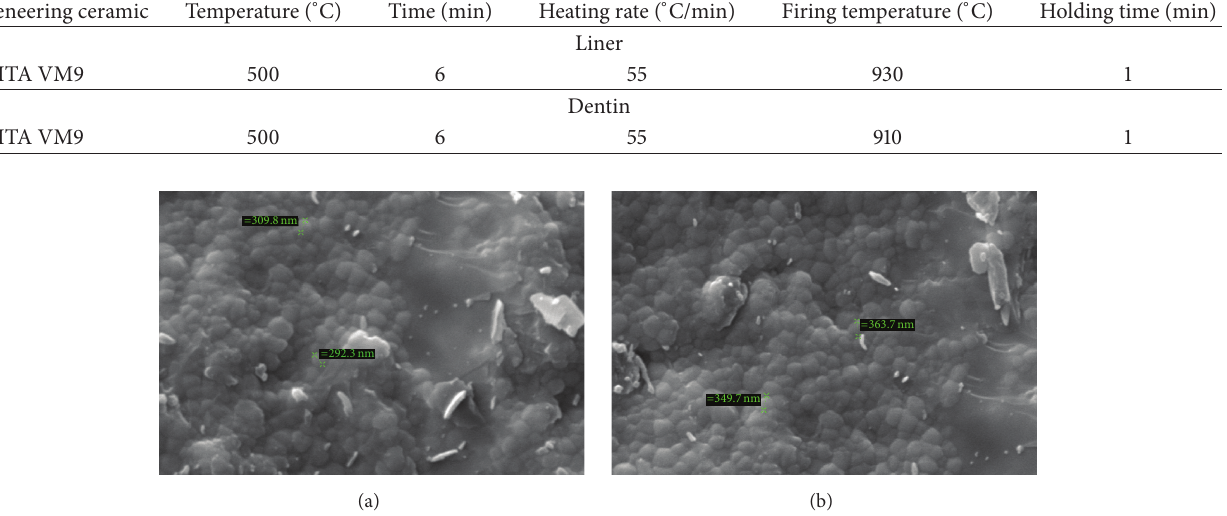
Table 4: Firing schedules of the veneering ceramic according to manufacturer.